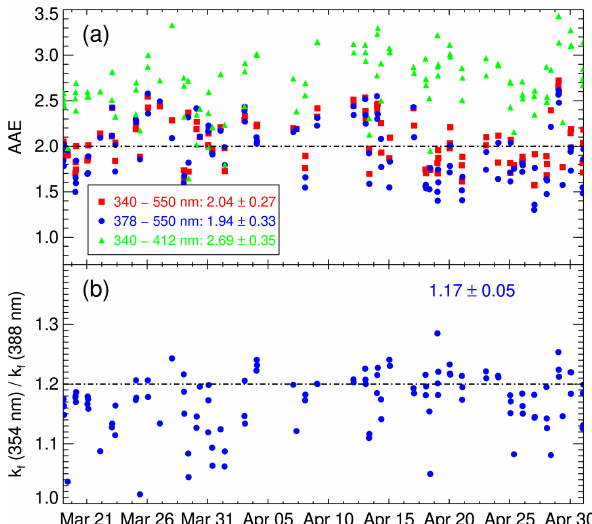
Figure 15. Temporal variations in the (a) AAE of aerosols and (b) ratio of fine-mode imaginary refractive indices ( k f ) of aerosols at 354 and 388nm retrieved at Fang, Thailand, in 2019. The color- coded symbols in panel (a) represent different wavelength pairs, with red for 340–550nm, blue for 378–550nm, and green for 340– 412nm. The dash-dotted lines in panels (a) and (b) are the as- sumed values of the ASHE and OMAERUV algorithms for smoke aerosols,